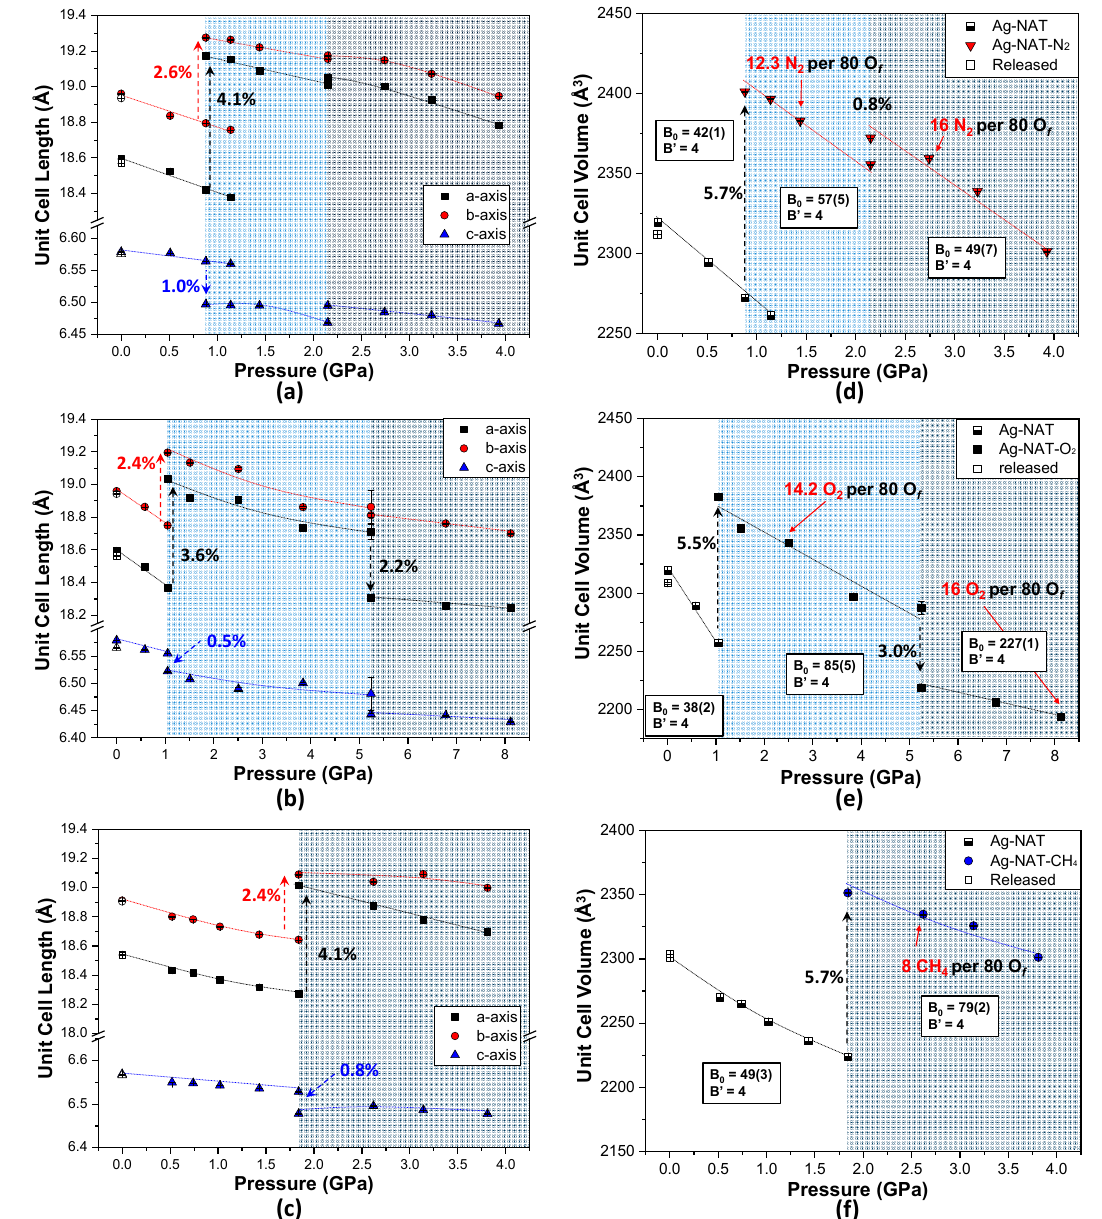
Figure 2. Pressure- and temperature-dependent axial changes of Ag-NAT in presence of ( a ) N 2 , ( b ) O 2 and ( c ) CH 4 and changes of unit cell volumes in presence of ( d ) N 2 , ( e ) O 2 and ( f ) CH 4 . Each open symbol represents volume after pressure released.